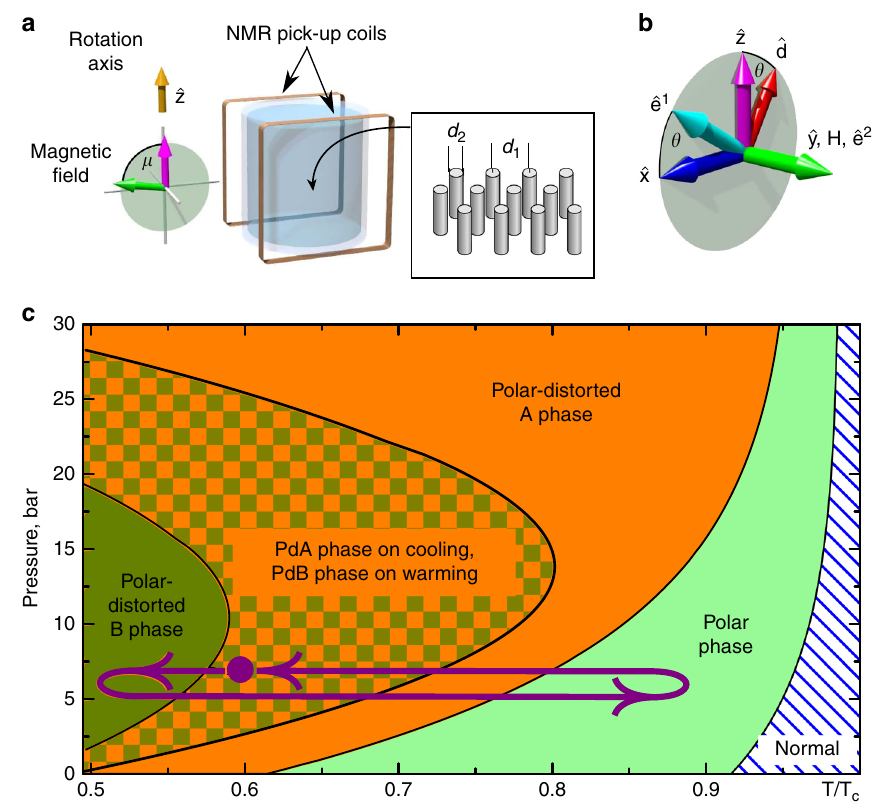
Fig. 1 The experimental setup and super fl uid phase diagram in nanocon fi nement. a The 3 He sample is con fi ned within a cylindrical container fi lled with commercially available nanomaterial called nafen-90 (where the number refers to its density in mg cm − 3 ) with uniaxial anisotropy, which consists of nearly parallel Al 2 O 3 strands with d 2 ≈ 8 nm diameter, separated by d 1 ≈ 50 nm on average. The strands are oriented predominantly along the axis denoted as ^ z . The sample can be rotated with angular velocities up to 3 rad s − 1 around the same axis ^ z . The sample is surrounded by rectangular nuclear magnetic resonance (NMR) pick-up coils. The static magnetic fi eld transverse to the NMR coils can be oriented at an arbitrary angle μ with respect to the ^ z axis. b The magnetic fi eld, oriented along the y -direction ( μ = π /2) in this fi gure, locks the ^ e 2 -vector in the polar-distorted B phase order parameter, Eq. (4). Vectors ^ d and ^ e 1 are free to rotate in the xz -plane by angle θ . c Sketch of the super fl uid phase diagram in our sample in units of T c of the bulk fl uid 31 . The purple arrows illustrate the thermal cycling used in the measurements and the purple marker shows a typical measurement point within the region where either polar-distorted phase can exist, depending on the direction of the temperature sweep. The thermal cycling is performed at constant 7 bar